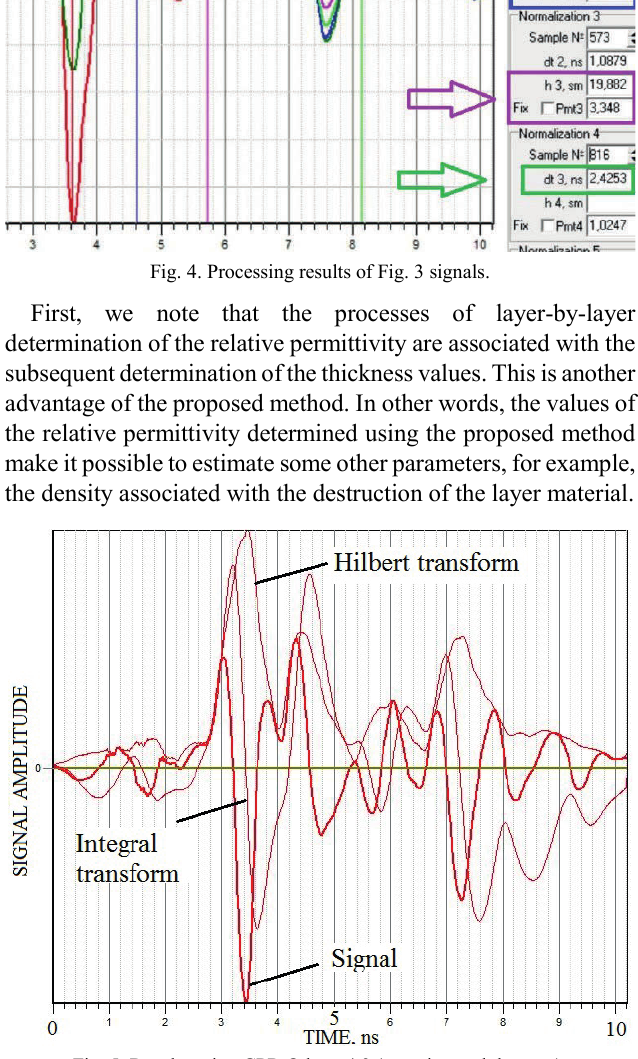
Fig. 5. Results using GPR Odyag-4.2 (experimental